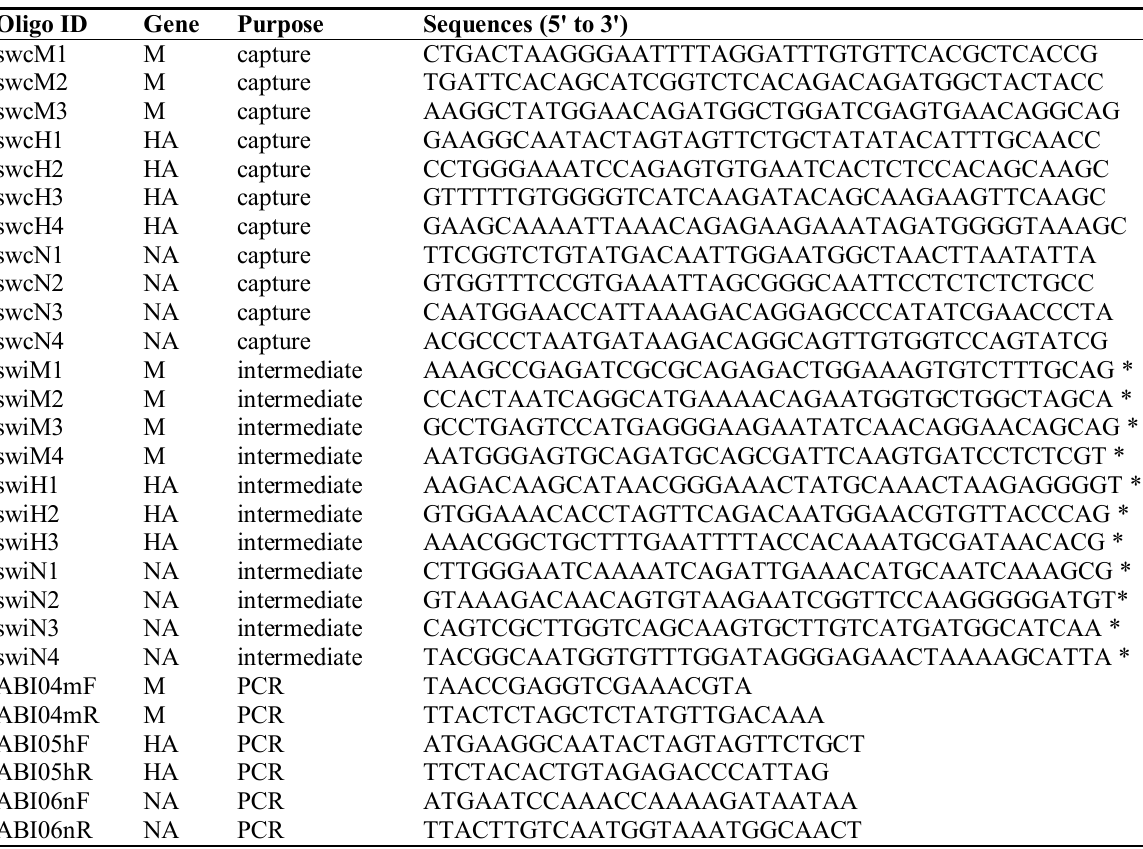
Table 1. Oligonucleotide sequences for H1N1/2009 capture (swc), intermediate (swi) and PCR. Oligo ID